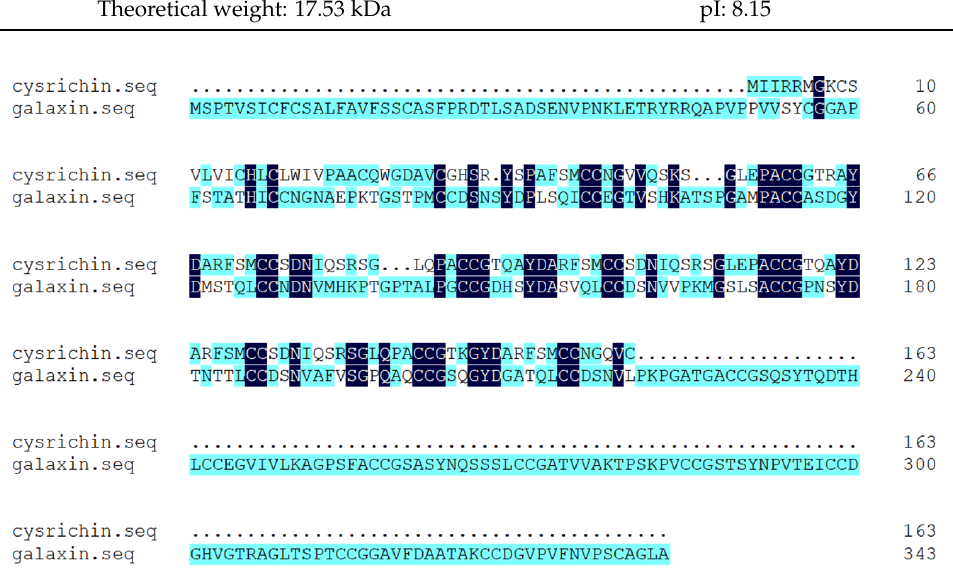
Figure 2. Alignment of amino acid sequences of cysrichin and galaxin. Note: the number on the right represents the position of the last amino acid.